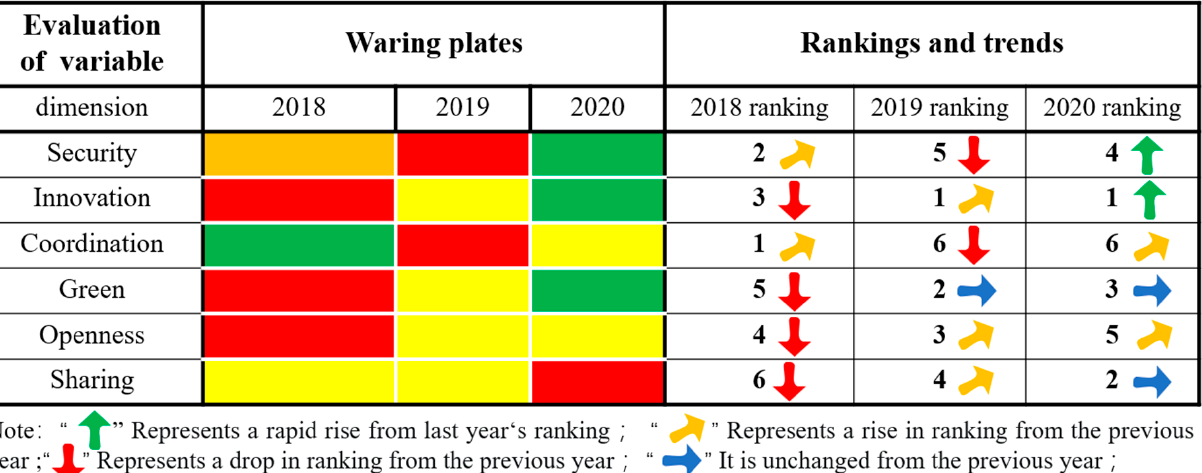
Figure 5. The results for six dimensions of city health examination and evaluation in Xining City.